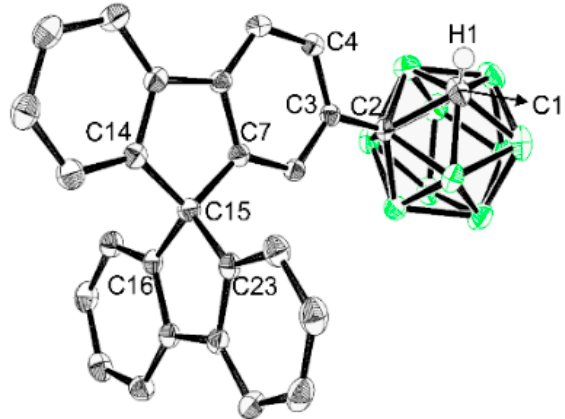
Figure 2. X-ray crystal structure of C1 (50% thermal ellipsoids). H atoms are omitted for clarity.